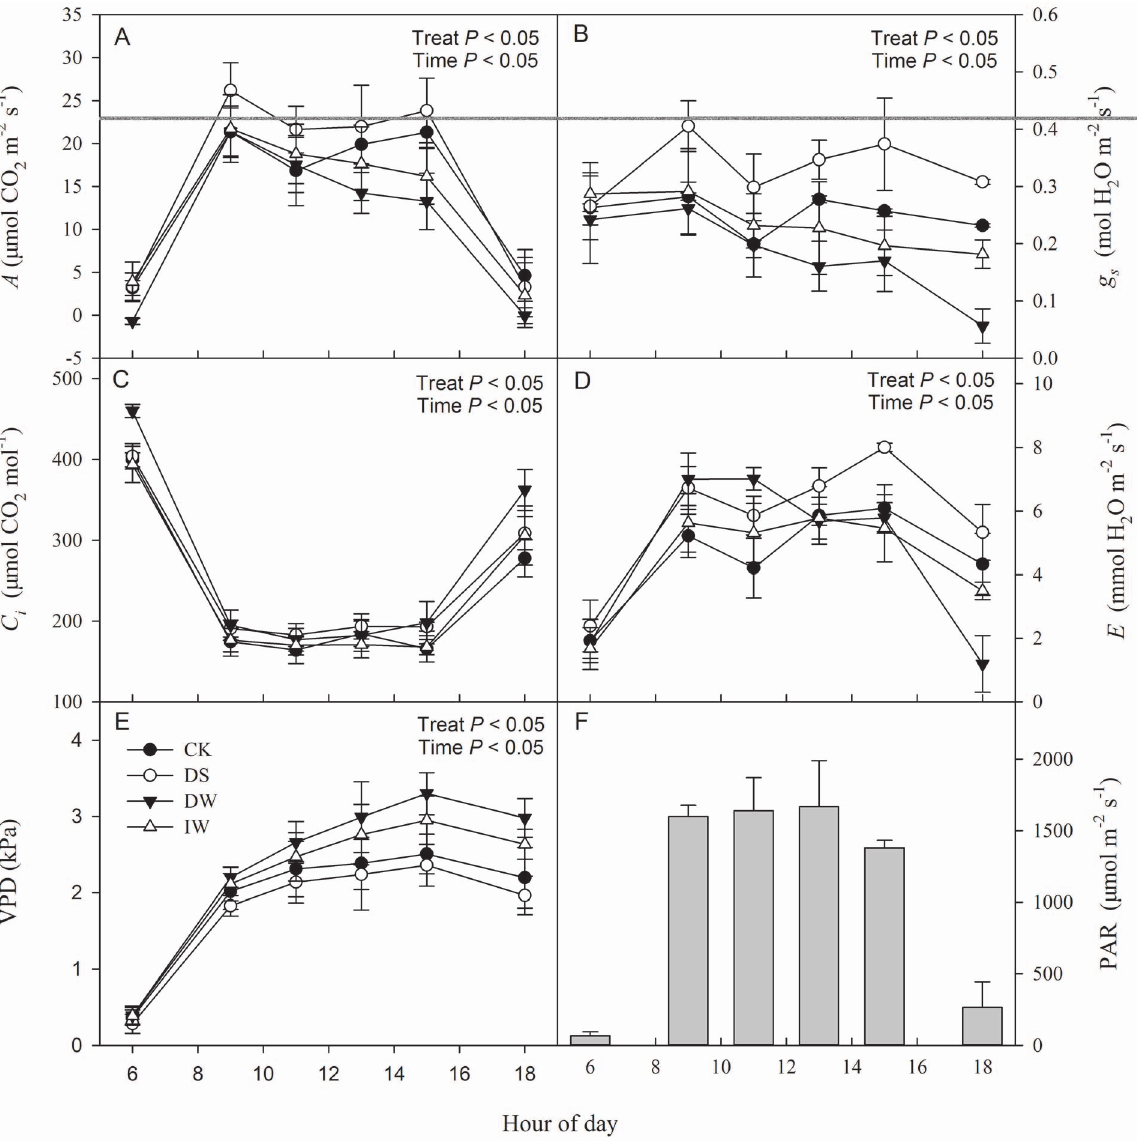
Figure 7. Diurnal changes in (A) assimilation rate ( A ), (B) stomatal conductance ( g s ), (C) intercellular CO 2 concentration ( C i ), (D) transpiration rate ( E ) and (E) atmospheric vapour pressure deficit (VPD) (mean ± SE) in winter wheat under four treatments (CK, DS, DW and IW), as well as (F) photosynthetic photon flux density (PAR) (E) in booting stage. P value represent the significance of the effects of each treatment.